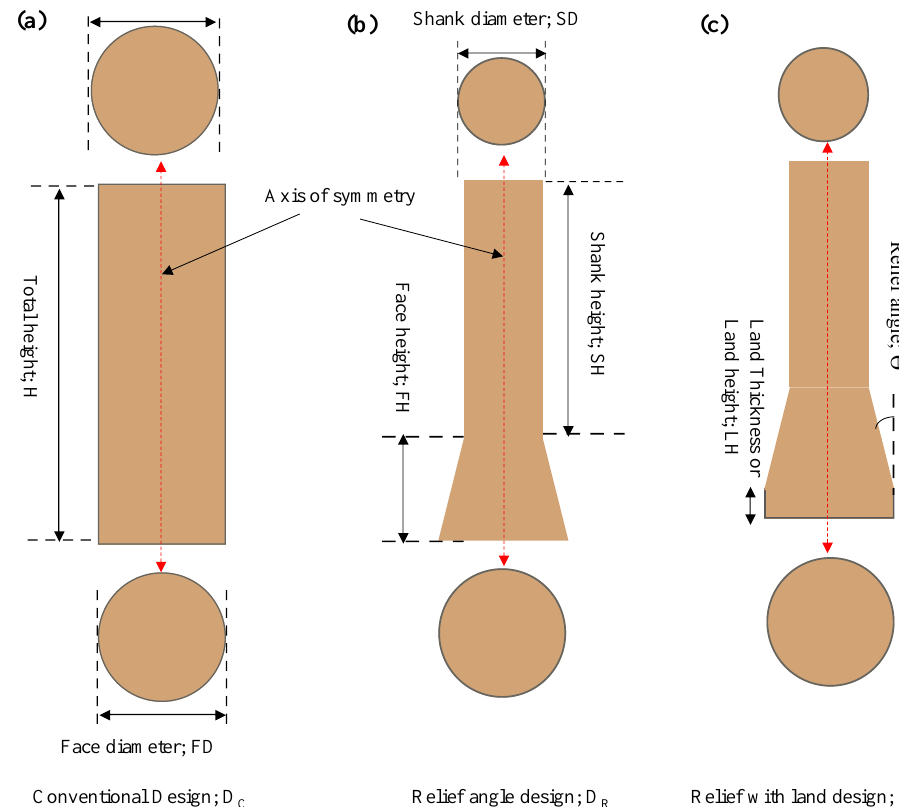
Figure 1. Schematic of electrode designs; ( a ) conventional, ( b ) relief angled, and ( c ) relief with land.